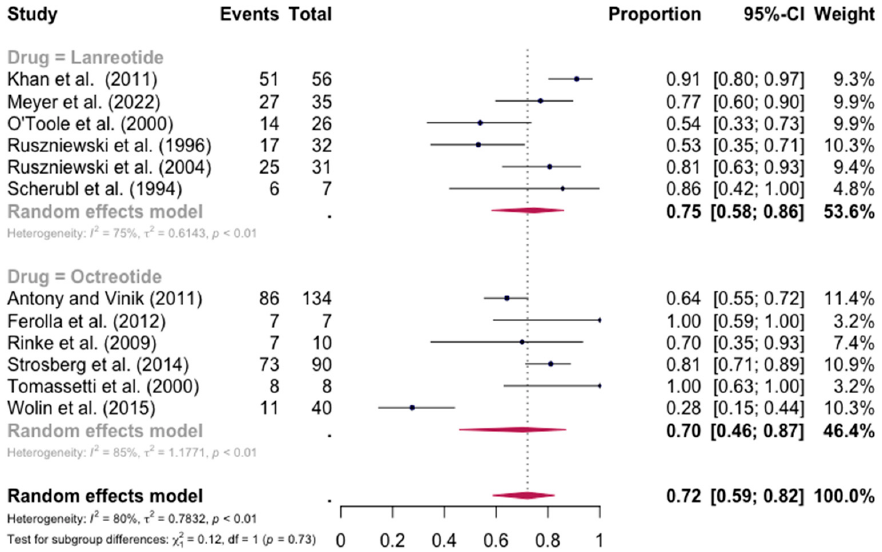
Figure 5. Forest plot demonstrating the pooled PR and CR for flushing in patients with carcinoid syndrome, after excluding patients under pasireotide treatment. CI: confidence interval, p: refers to Cochran’s Q test for heterogeneity [21,22,34,47-51,56,58-60] .